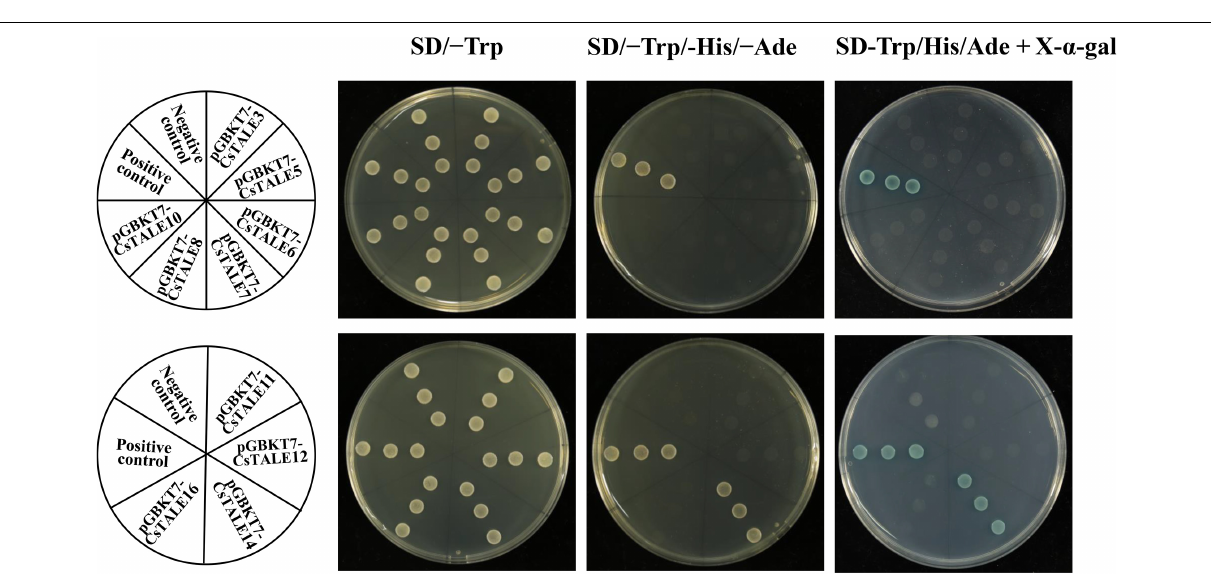
( Figure 7 ). pGBKT7- Cs TALE14 co-transformed yeast cells grew well on SD/–Trp/–Leu medium and turned blue on X- α - gal-supplemented SD–Trp/His/Ade medium, thereby indicating that they have transcriptional activation ability. However, yeast